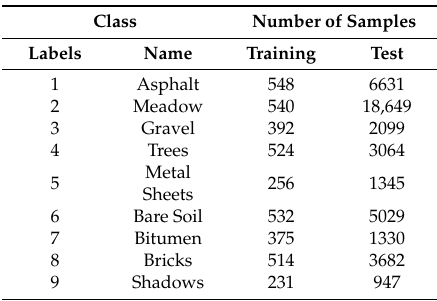
Table 1. University of Pavia dataset: number of training and test samples.